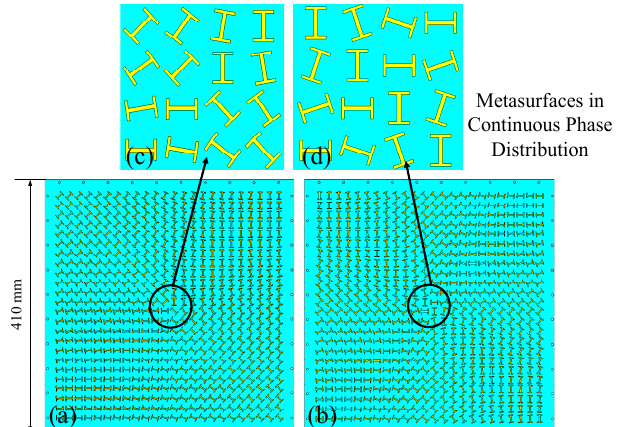
Figure 4. The simulation model of the proposed metasurfaces in continuous phase distribution: ( a ) Front view of the metasurface generating OAM order of 1. ( b ) Front view of the metasurface generating OAM order of 2. ( c ) Detailed view of the metasurface generating OAM order of 1. ( d ) Detailed view of the metasurface generating OAM order of 2.